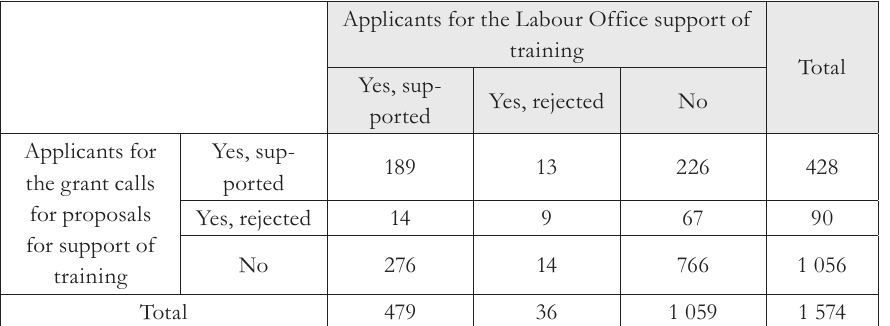
Tab. 3 – Combination of the two types of the ESF assistance in firms. Source: Survey, own